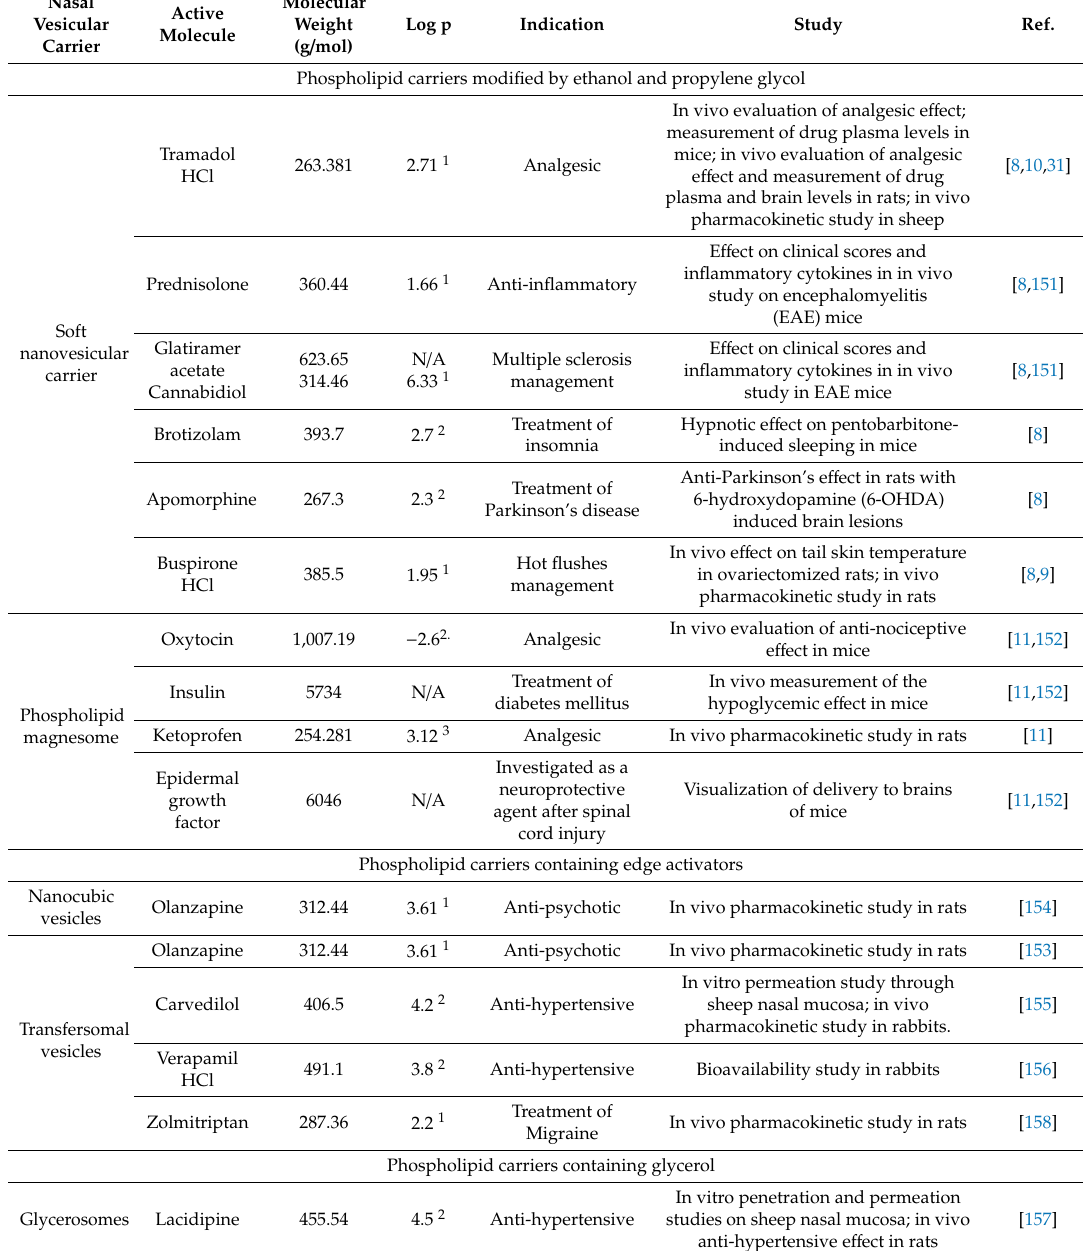
Table 6. Active molecules investigated using phospholipid vesicular carriers for nasal administration (presented in chronological